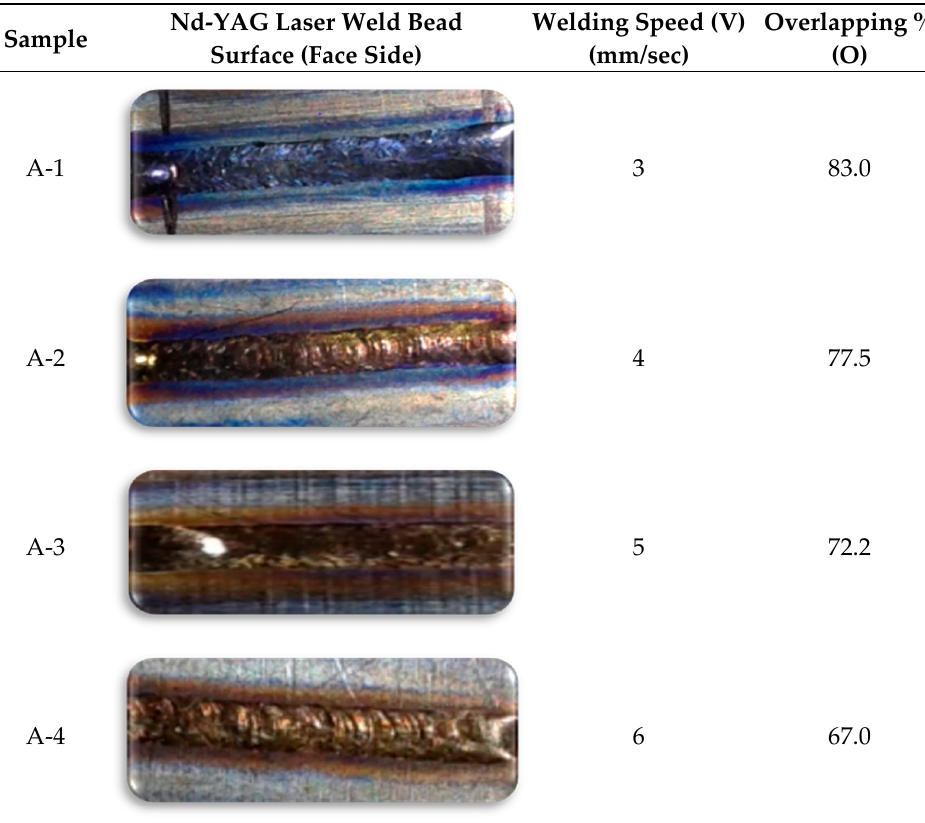
Figure 3. Face side images of the weld bead with different overlapping percentages and welding